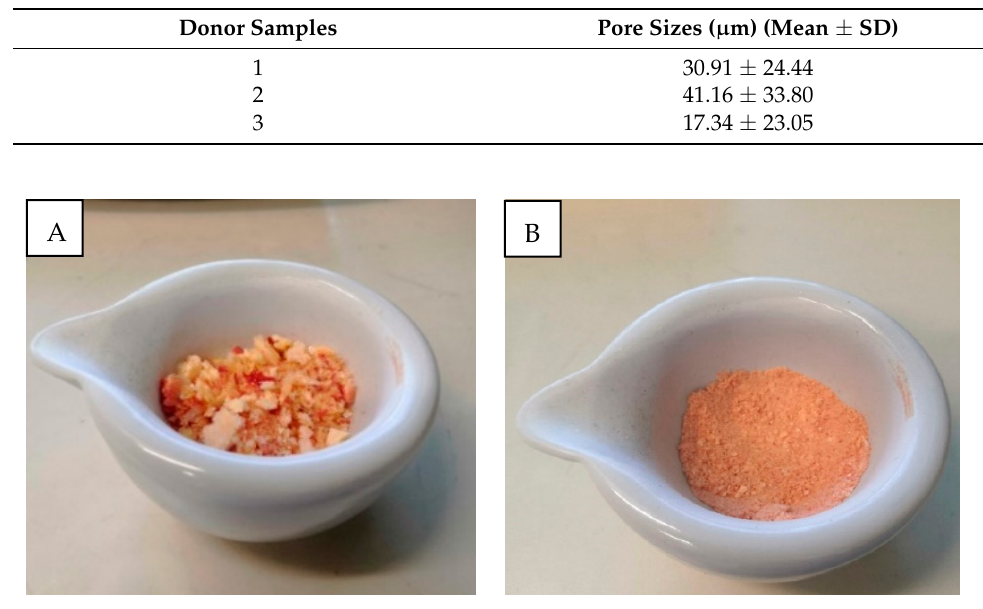
Figure 2. Physical appearance of lyophilised PRF. Ly-PRF ( A ) before and ( B ) after being ground into granules using a mortar and pestle. Table 2. Comparative Ly-PRF pore sizes.